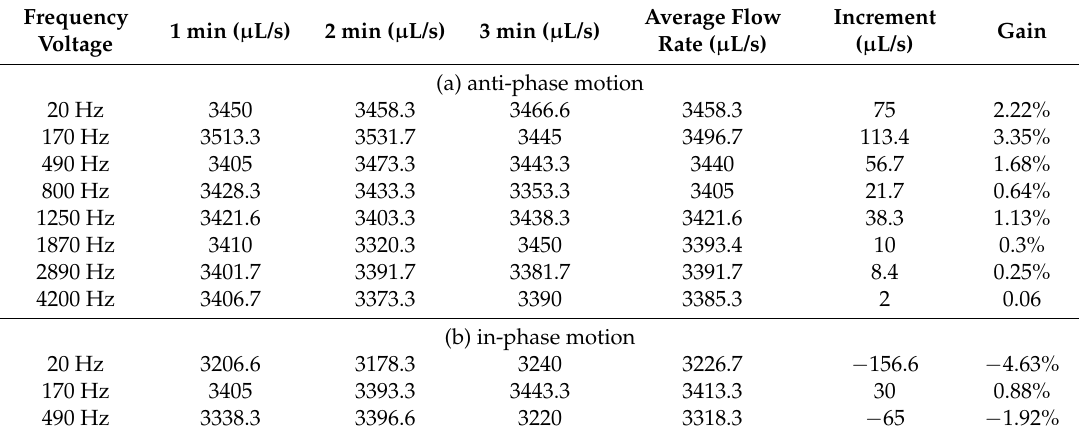
Table 6. The average flow rate and gain of the pumping element.